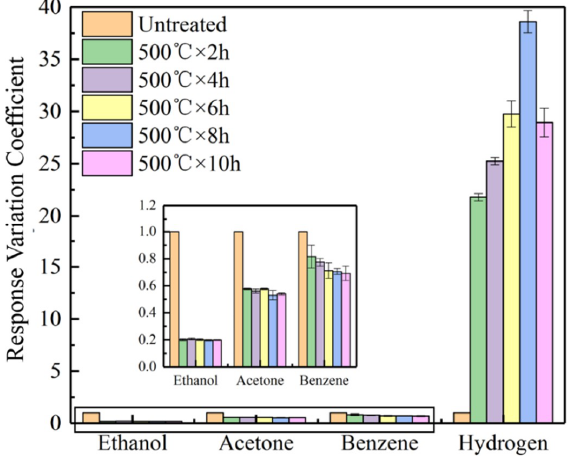
Figure 12. The response variation coefficients of the CVD-treated sensors at 500  C with exposure to 1000 ppm hydrogen at 350  C. 1000 ppm hydrogen at 350 ◦